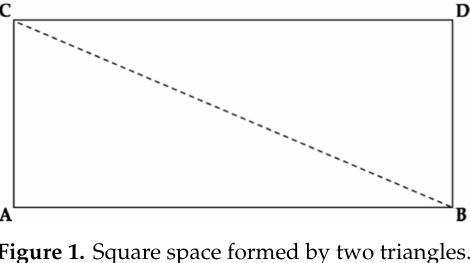
Figure 1. Square space formed by two triangles.